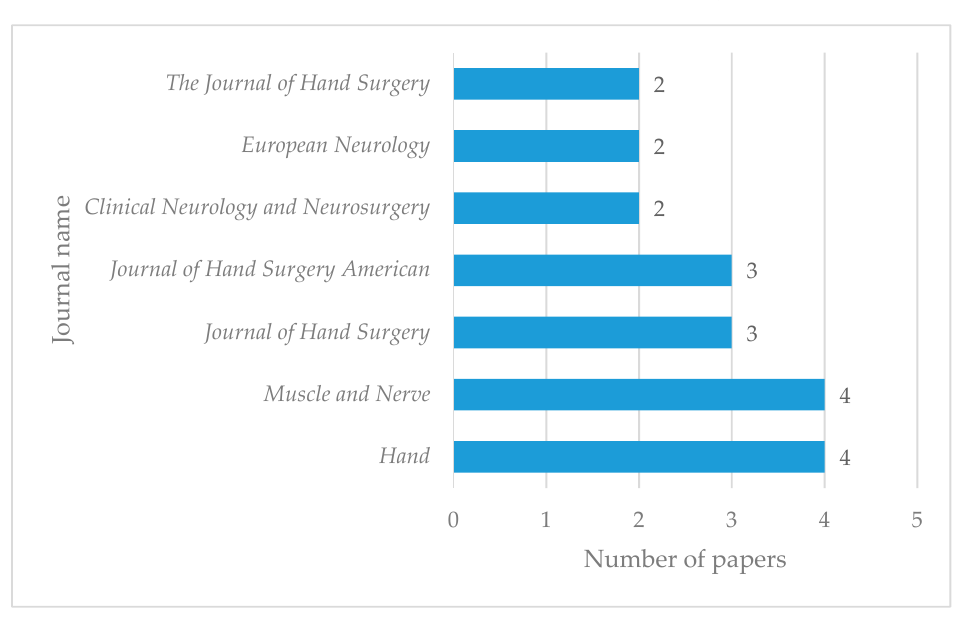
Figure 2. Journals published on CTS (only those with at least two articles included in the study are shown here).